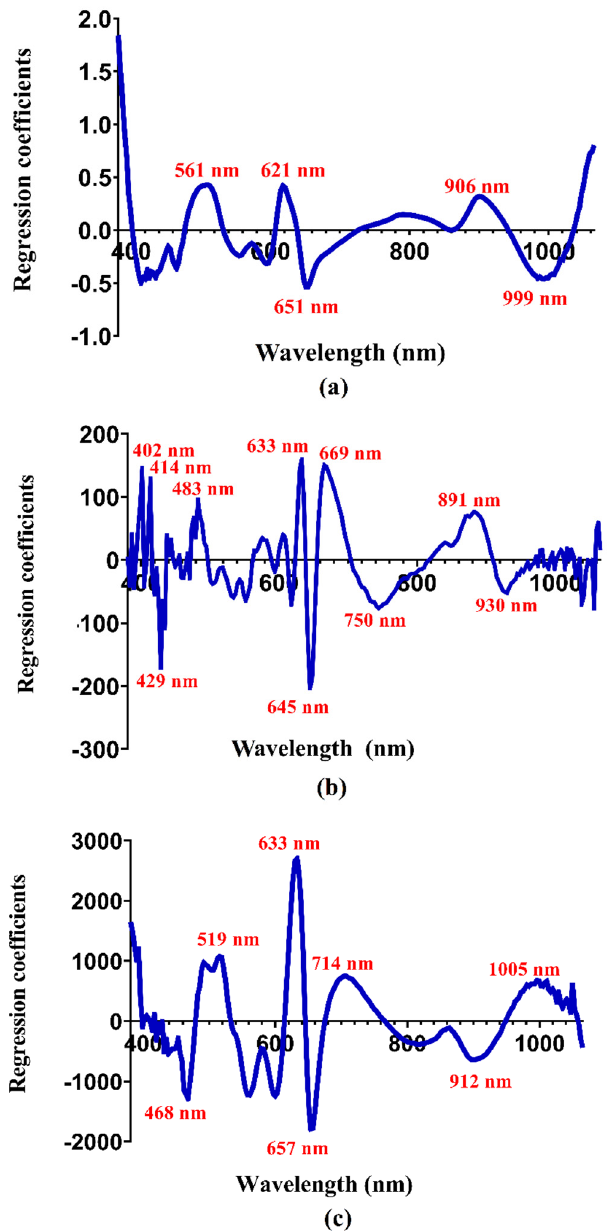
Figure 3. Regression coefficients: ( a ) water content, ( b ) total carotenoids, and ( c ) capsaicin of green ‘Ratuni UNPAD’ cayenne pepper.